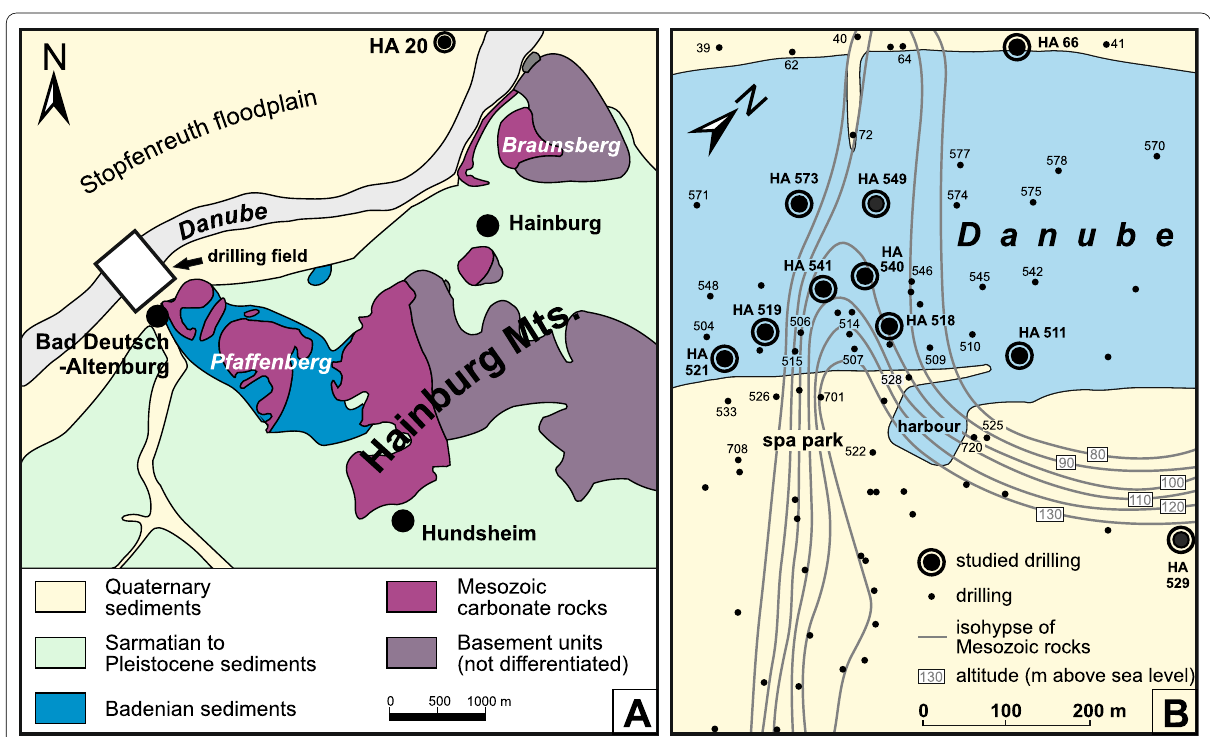
Fig. 3 A Simplified geological map of the Hainburg Mountains between Bad Deutsch-Altenburg and Hainburg (modified after Fuchs, 1985) and the location of the drilling field. B The drilling field at Bad Deutsch-Altenburg with all drillings and the studied drill sites indicated; the contour lines (isohypses) reflect the morphology of the Triassic dolomite ridge (modified after Gangl,